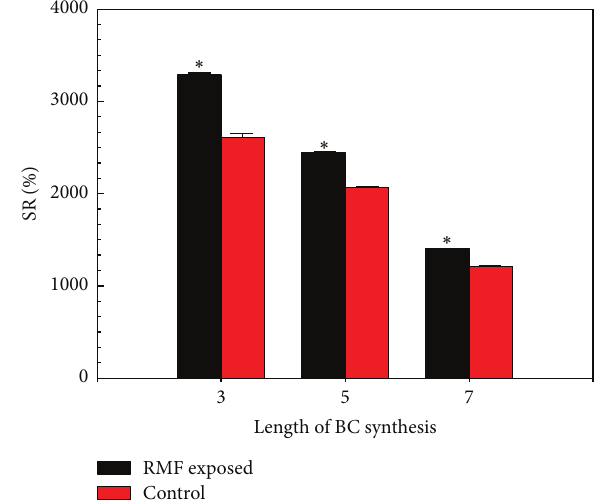
Figure 8: The swelling behavior of control and RMF exposed BC pellicles. Data are expressed as percentage of swelling ratio (%SR) calculated by (1) and presented as a mean ± standard error of the mean (SEM). ∗ Statistically significant difference between RMF exposed BC and control BC (Student’s 𝑡 -test, 𝑃 < 0.05